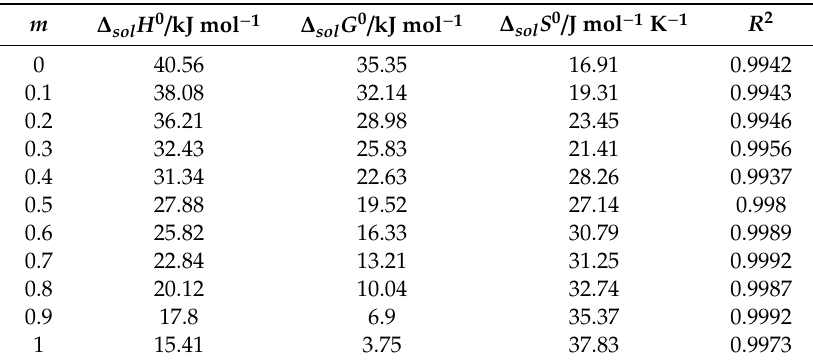
Table 4. Apparent standard enthalpy ( ∆ sol H 0 ), apparent standard Gibbs energy ( ∆ sol G 0 ), apparent standard entropy ( ∆ sol S 0 ) and determination coe ffi cient ( R 2 ) values for FFA dissolution in various Carbitol + water mixtures ( m ) b . 0 / kJ mol − m ∆ sol H